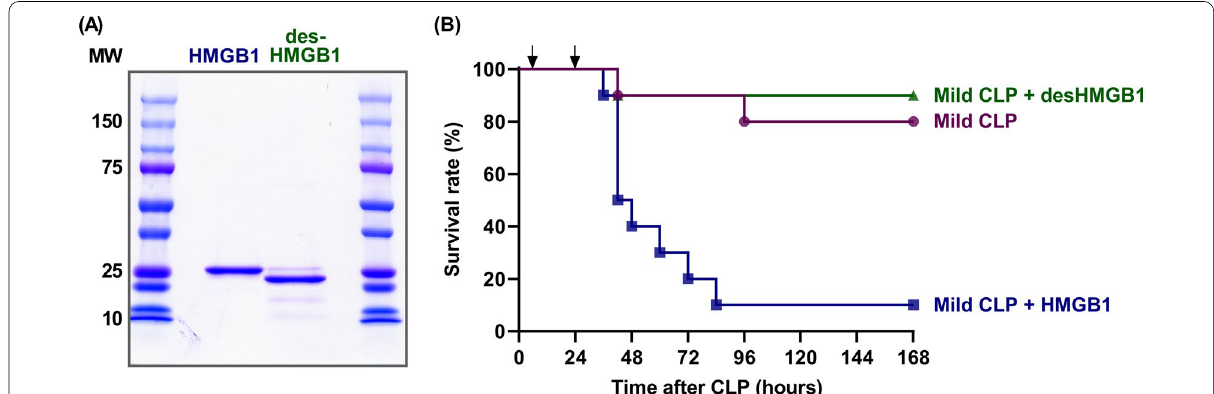
Fig. 1 Impact of HMGB1 or desHMGB1 administration on cecal ligation and puncture (CLP)-induced sepsis in mice. A Purity of HMGB1 (2 μg/lane) and desHMGB1 (2 μg/lane) was analyzed using sodium dodecyl sulfate-polyacrylamide gel electrophoresis (SDS-PAGE) followed by Coomassie Brilliant Blue (CBB) staining. B Male C57BL/6J mice were subjected to a mild model of CLP-induced sepsis. Mice were randomly divided into the following three groups, each containing 10 animals: CLP alone, CLP with HMGB1 administration, and CLP with desHMGB1 administration. Either 2 mg/kg of HMGB1, 2 mg/kg of desHMGB1, or an equal volume of saline was administered into the tail veins of mice at 6 and 24 h after CLP (the time points are indicated by arrows), and the survival rate was monitored for 7 days. The survival rate of the CLP with HMGB1 group was significantly lower than that of the CLP with desHMGB1 group or the CLP alone group ( P < 0.01, log-rank